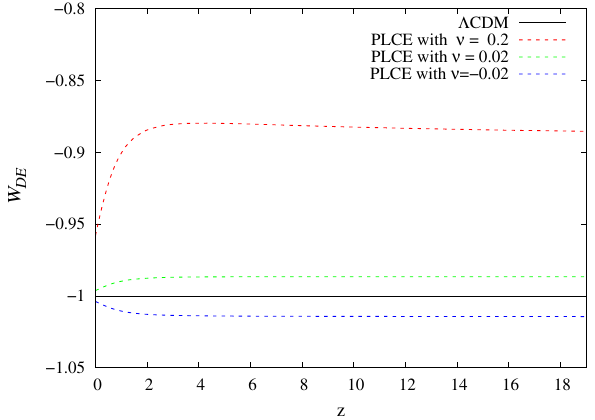
Fig. 1 Evolutions of the equation-of-state parameter w DE in (cid:2) CDM and PLCE models